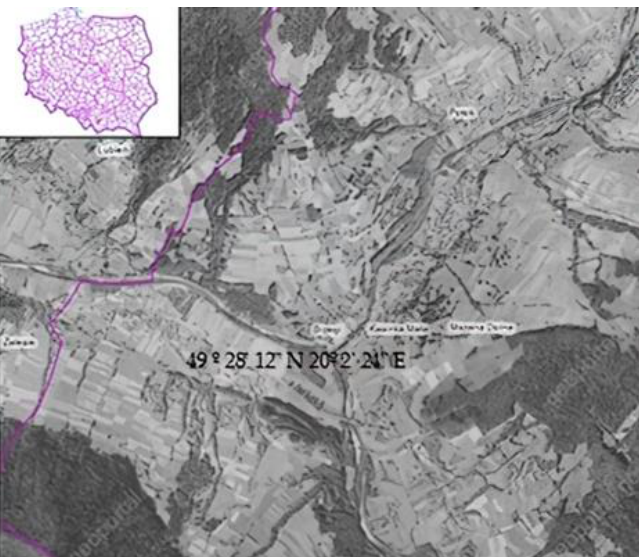
Figure 1. The study area — Kasinka Mala .